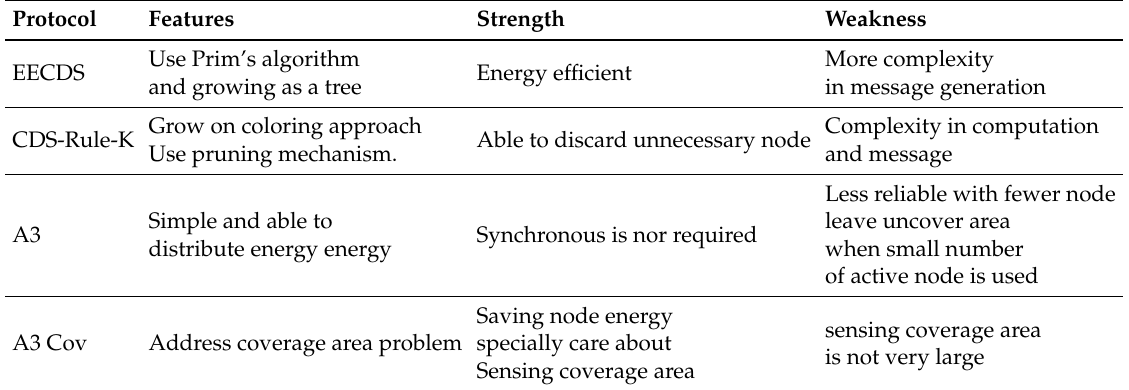
Table 1. List of major features, strength and weakness for relevant